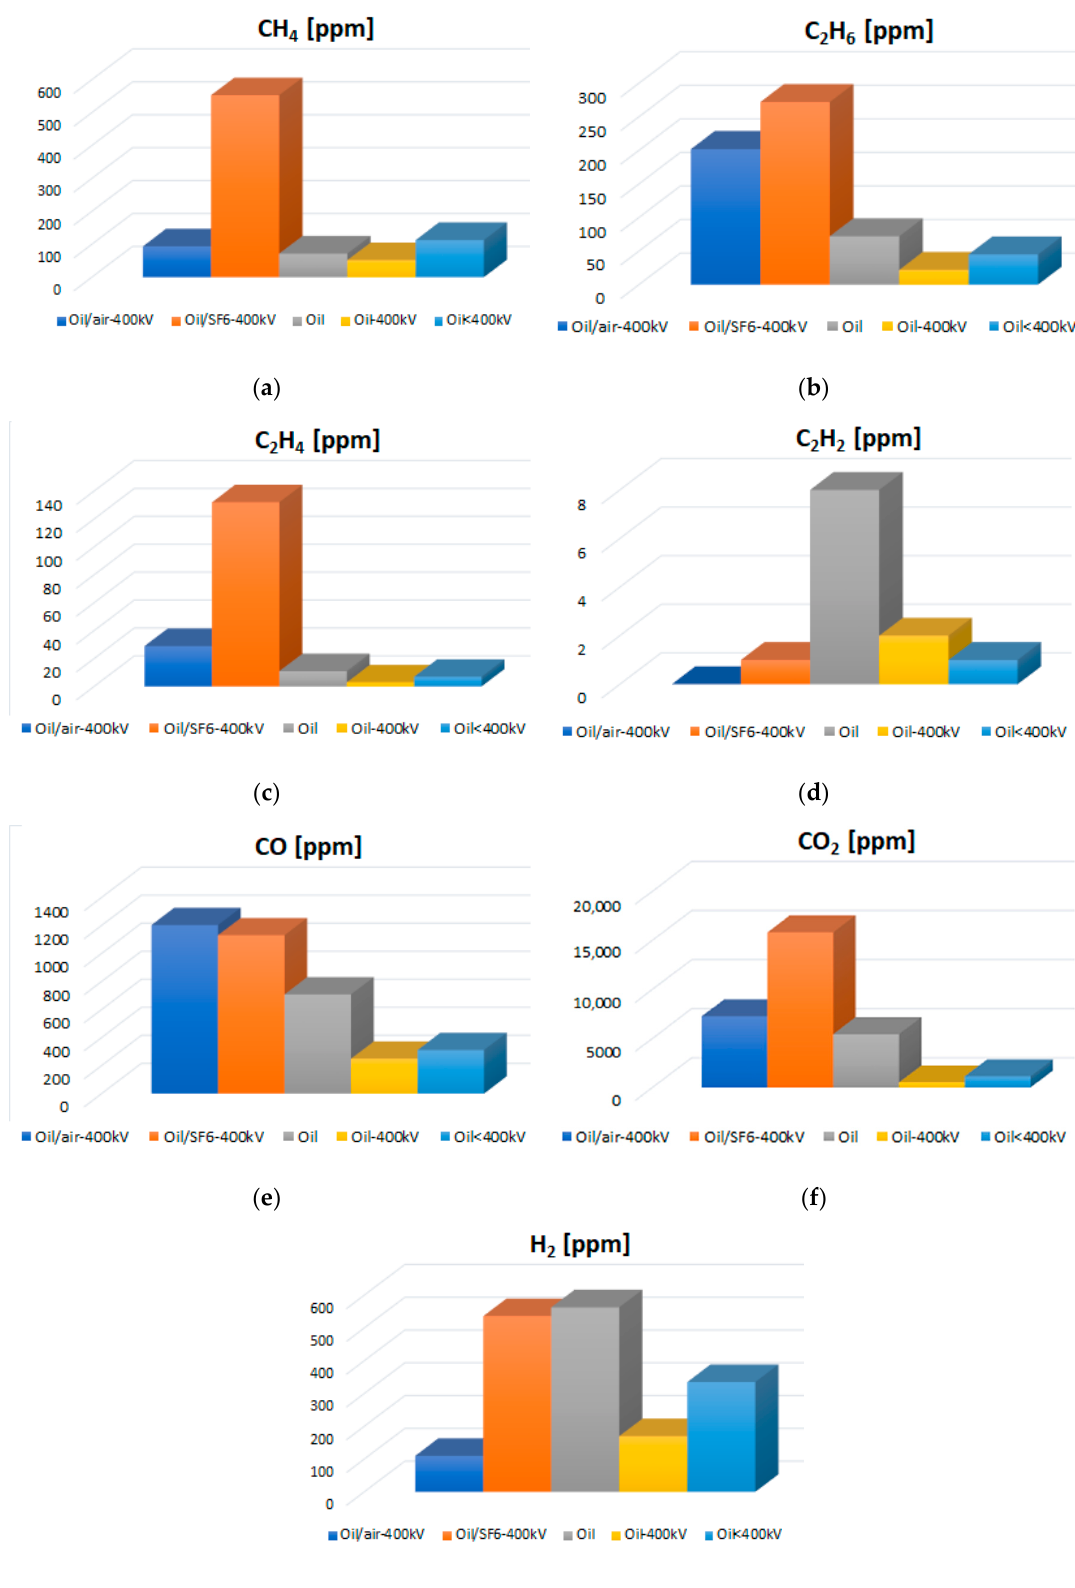
Figure 1. The 95% typical values of gas concentrations in bushings proposed in the CIGRE brochure 771: ( a ) CH 4 , ( b ) C 2 H6, ( c ) C 2 H 4 , ( d ) C 2 H 2 , ( e ) CO, ( f ) CO 2 , ( g ) H 2